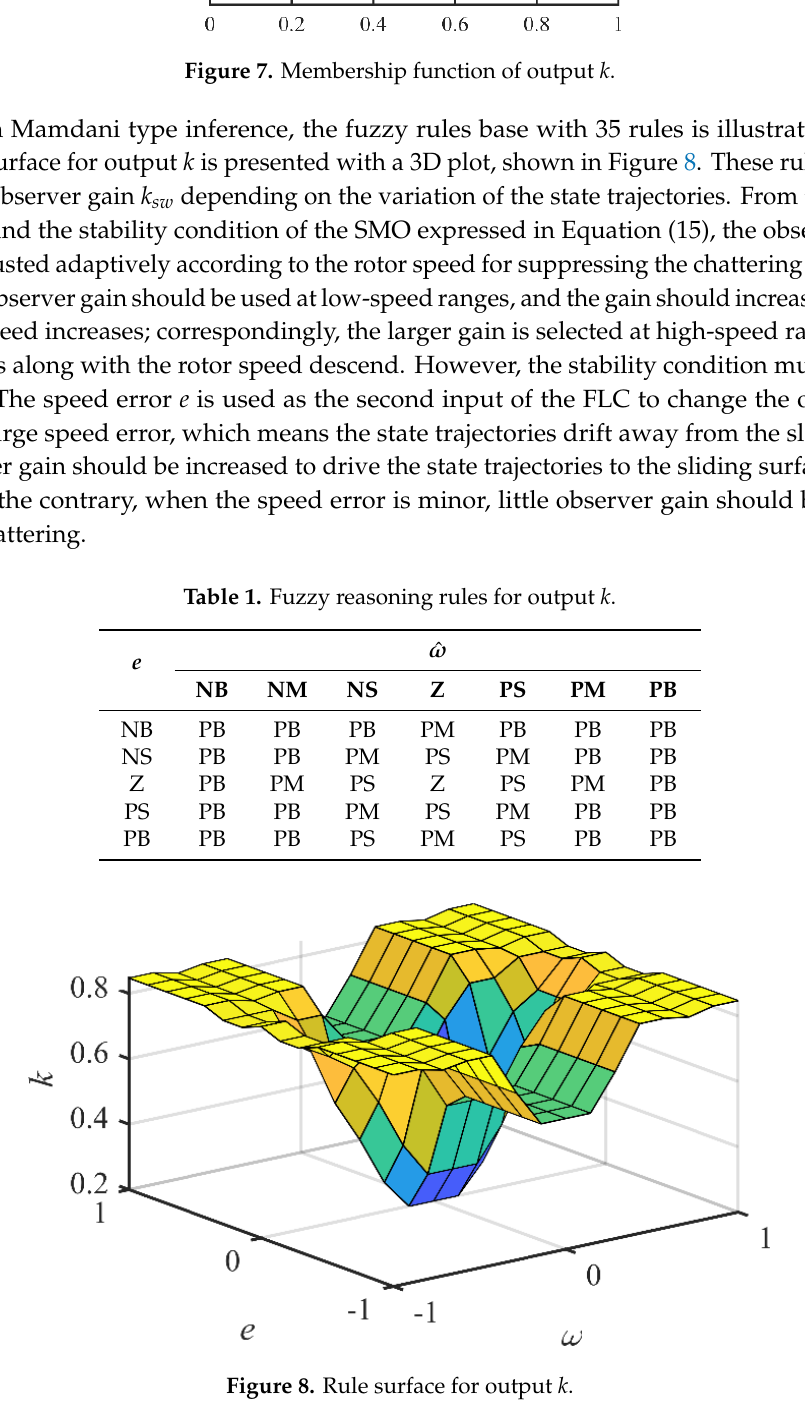
Figure 7. Membership function of output k .